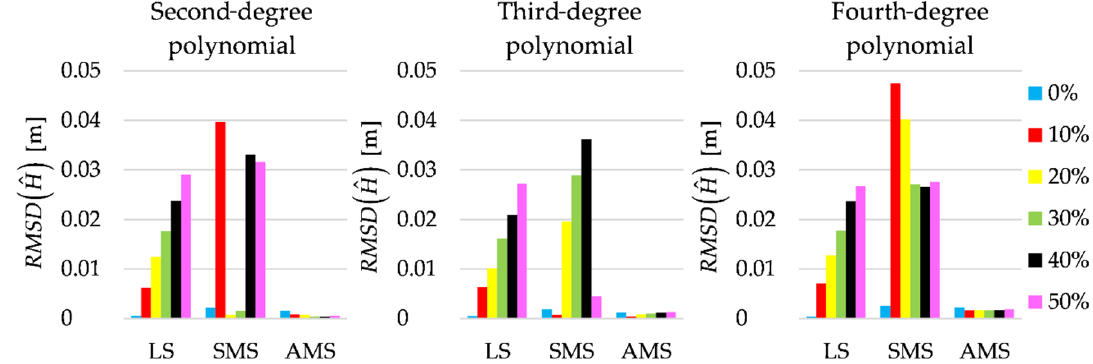
( ) ˆ RMSD H for LS, SMS and AMS estimates for different percentages of outliers. Figure 5. RMSD (cid:0) ˆ H (cid:1) for LS, SMS and AMS estimates for different percentages of Figure 5.